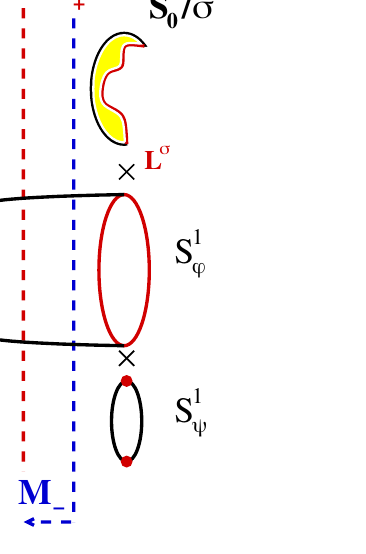
is given r;a;(cid:14)